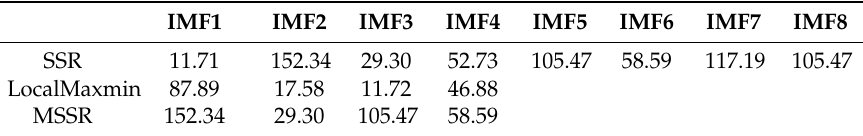
Table 4. The experimental results of outer race of motor